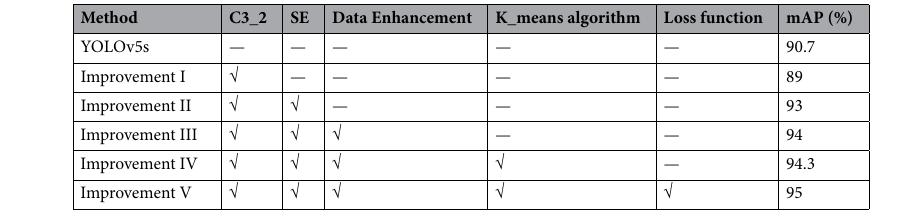
Table 3. Results of object recognition using the improved YOLOv5s